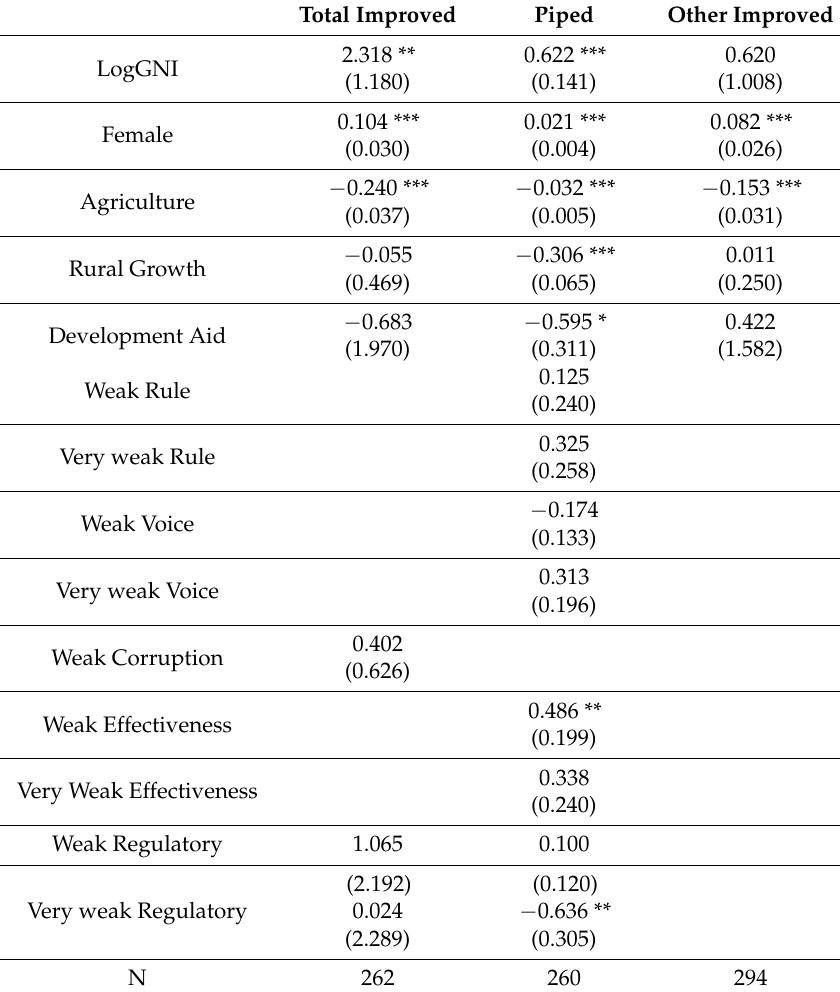
Table 7. Socioeconomic indicators. Low income